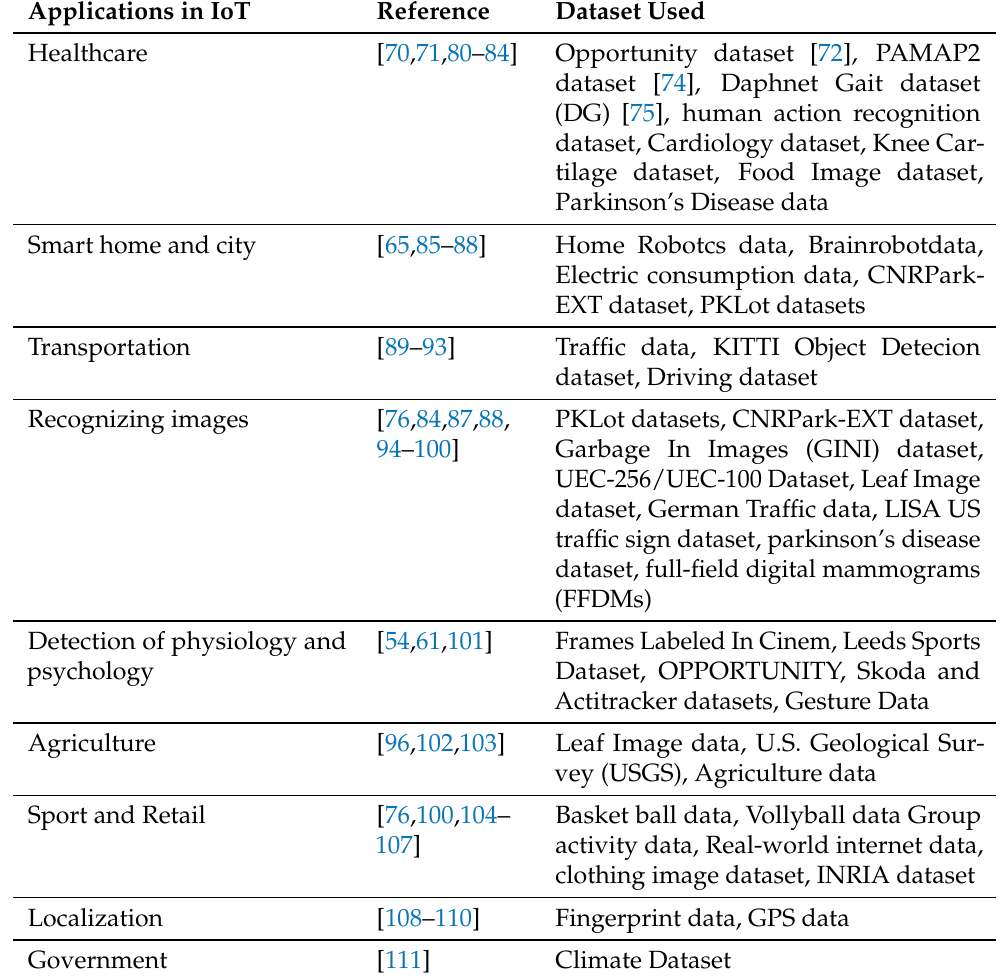
Table 3. CNN model in IoT